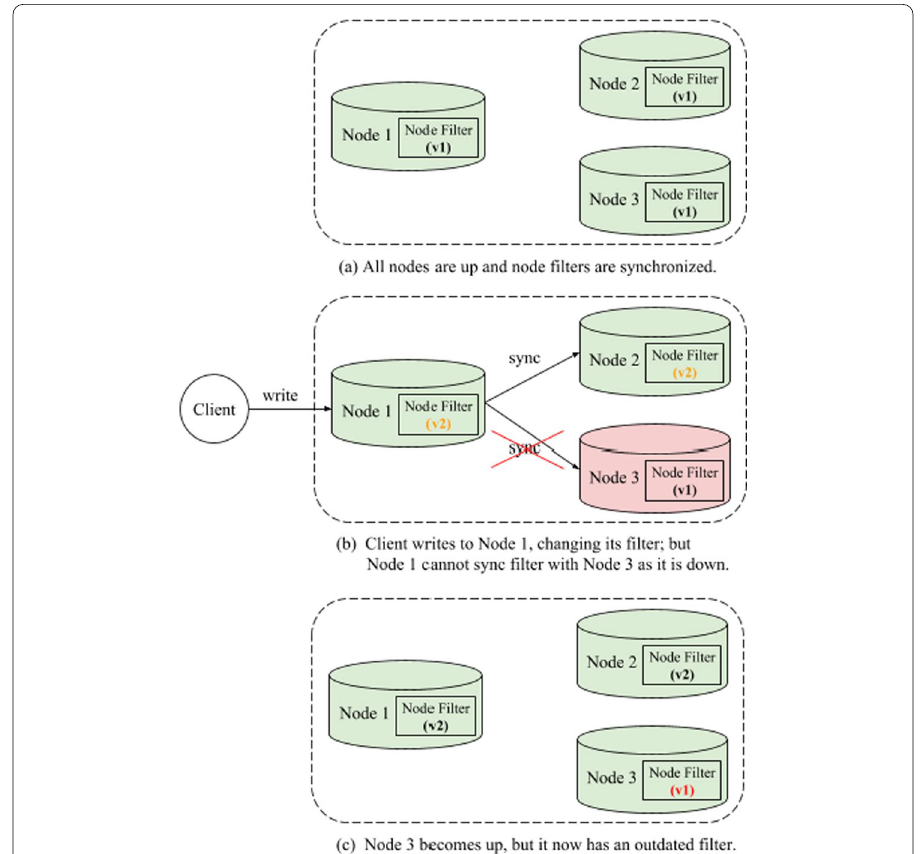
Fig. 19 Node filter synchronization issue during failure of a